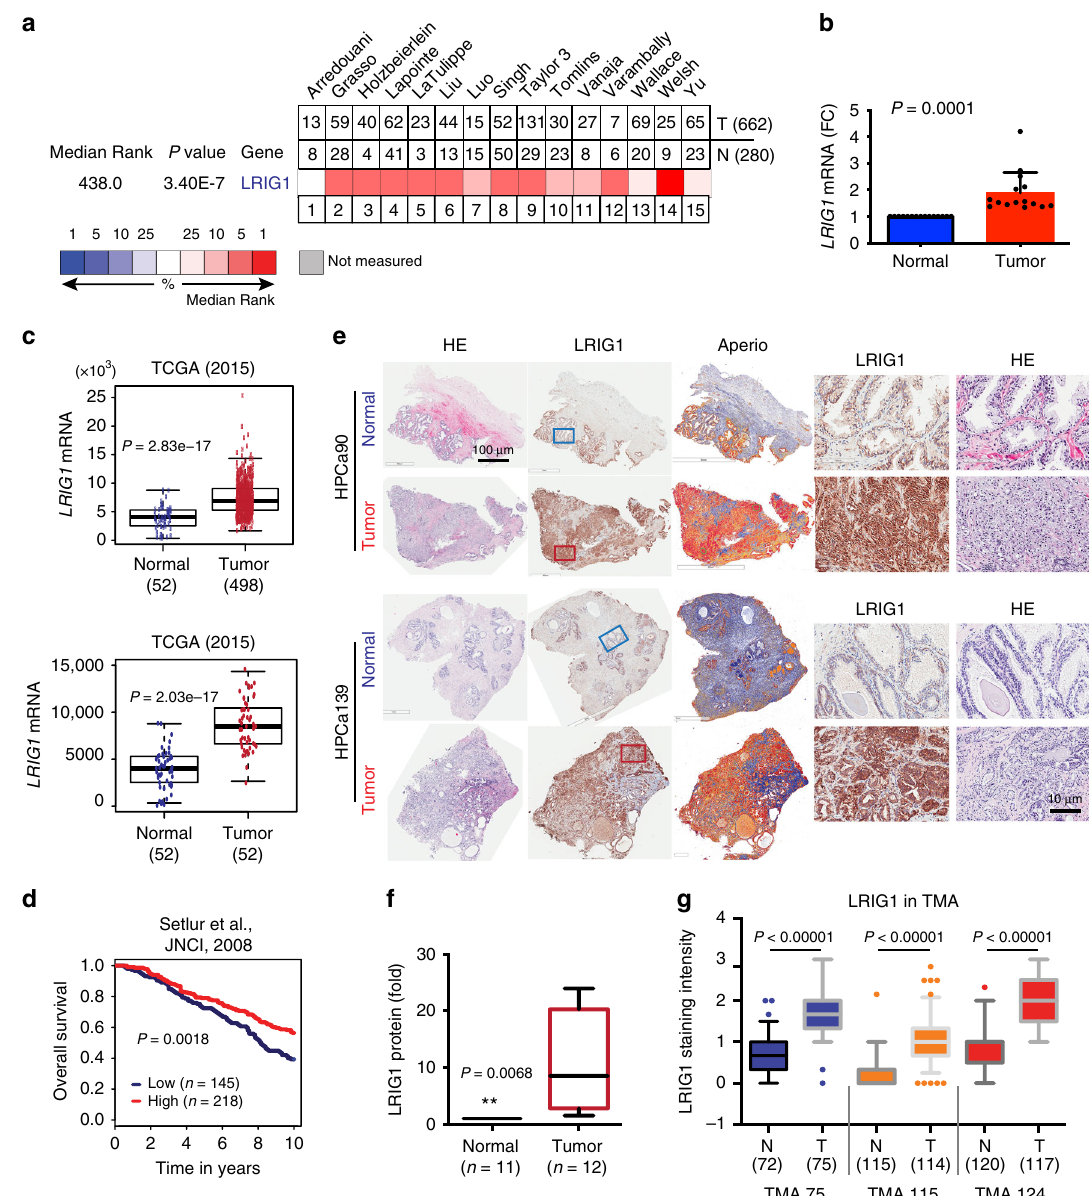
Fig. 1 Overexpression of LRIG1 in PCa and correlation with better patient survival. a – c Elevated LRIG1 mRNA in PCa in Oncomine ( a , b ) and in TCGA ( c ). In b , the LRIG1 mRNA levels were extracted from tumors (T) in the 15 Oncomine datasets ( a ) and presented as fold changes (FC) after normalizing to the corresponding normal/benign tissues (N). The error bar represents the mean±S.D. In c , the center lines represent median values, box edges are 75th and 25th percentiles, and whiskers represent the maximum and minimum values, respectively. d High LRIG1 mRNA levels correlate with better patient overall survival (the Setlur dataset). P -value was determined using the Log-Rank test. e , f Prostate tumors overexpress LRIG1 protein. Shown in e is LRIG1 IHC (using Sigma mAb, 1:100 dilution) in 2 HPCa (i.e., HPCa90 and HPCa139) and matched benign tissues. Enlarged images of boxed regions are shown on the right. Scale bars are indicated in one representative whole-mount (left) and enlarged (right) image, respectively. In f , whole-mount slides were scanned by Aperio Scanscope and used to quantify LRIG1 expression levels. The centerline represents the median, box edges are 75th and 25th percentiles, and whiskers represent maximum and minimum values. g Increased LRIG1 protein expression in PCa. LRIG1 staining intensity was determined in 3 TMAs that contained both tumors (T) and normal (N) tissues (total numbers indicated below). The centerline represents the median, box edges are 75th and 25th percentiles, and whiskers represent 95% and 5% values, respectively. The P -values in b , c , f , and g were determined by two-tailed unpaired Student ’ s t -test. *Source data for Fig. 1f, g are provided as a Source Data fi